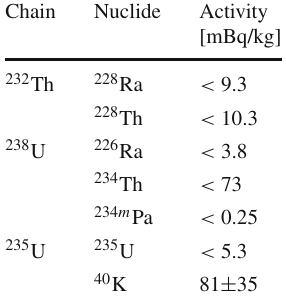
contamination of the polymer-resin used for the 3D-printing of the detector assembling tools (3SP